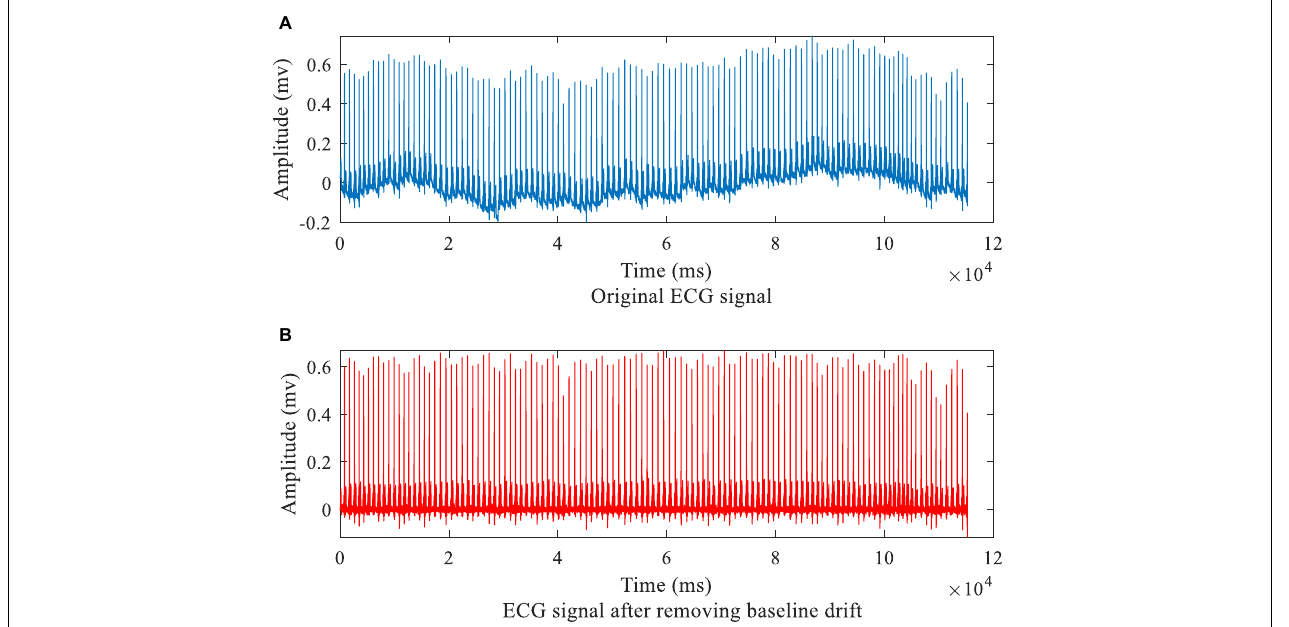
FIGURE 1 | ECG signal before (A) and after (B)